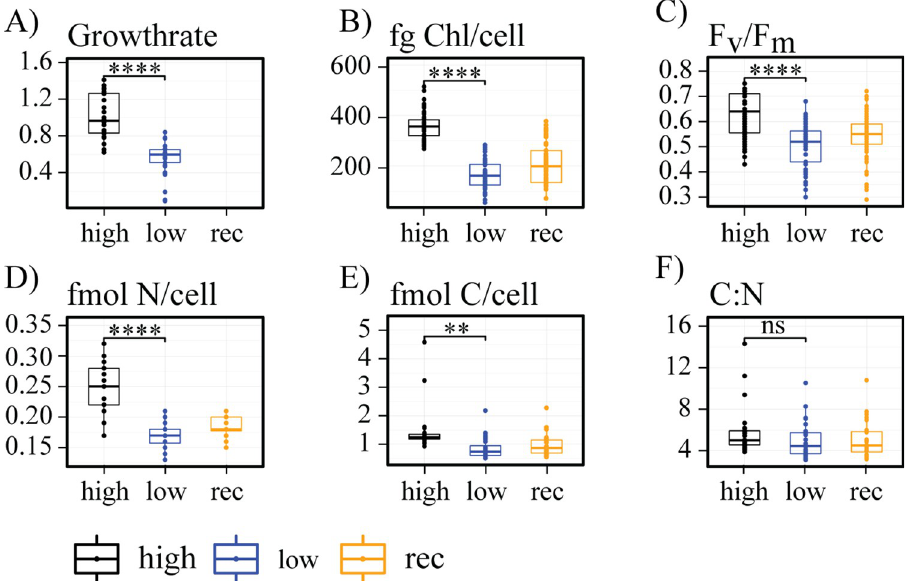
Fig 4. Comparison of physiological parameters in low-iron, high-iron, and iron-recovery samples. Characterization of cells grown under low-iron, high-iron, and iron-recovery conditions. High-iron samples are black, low-iron samples are blue, and iron-recovery samples are shown in orange. Results from ST- and the LT-experiment are combined, with every dot representing one sample. We used a two-tailed Student’s T-test for statistical analysis between high-iron and low-iron cultures. Statistically significant P values are indicated as � < 0.05, �� < 0.01, ��� < 0.001, ���� < 0.0001. A line without stars indicates a test that is not statistically significant. (A) Growth rates μ [day -1 ]. (B) Chlorophyll content per cell (fg/cell). (C) F v /F m measurements of all timepoints measured during LT- and ST- experiment. (D) Nitrogen/cell in fmol/cell. (E) Carbon/cell in fmol/cell. (F) C:N molar